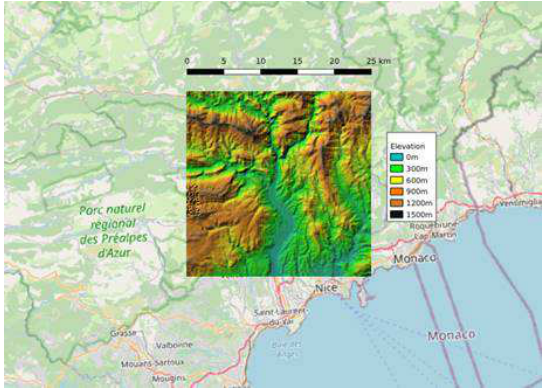
Figure 9: DSM tile generated in mass production